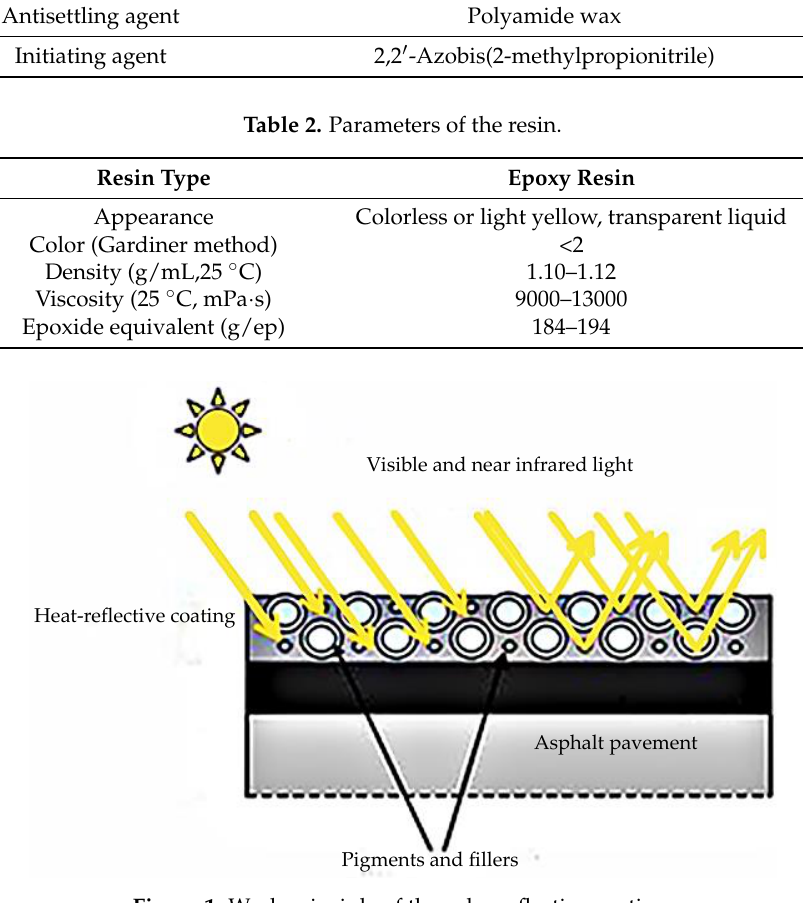
Figure 1. Work principle of the solar reflective coating. Table 3. Reflectivity of the coatings.